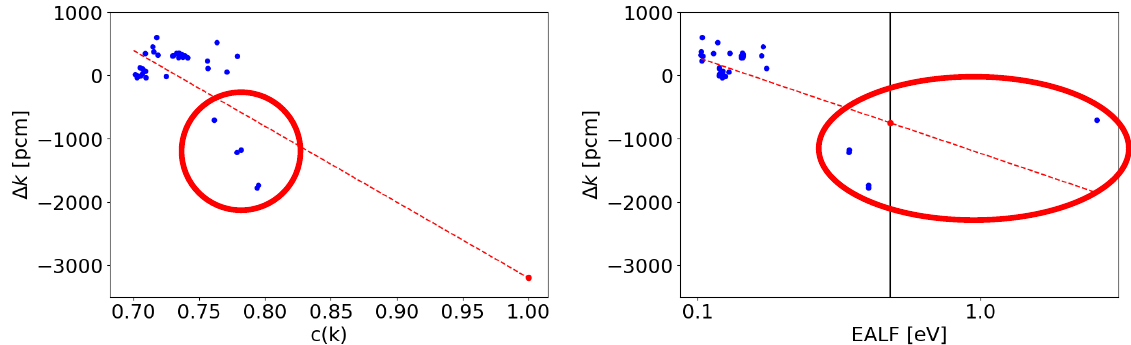
Figure 2b and 2c. The error between the model and the corresponding experiment as a function of c